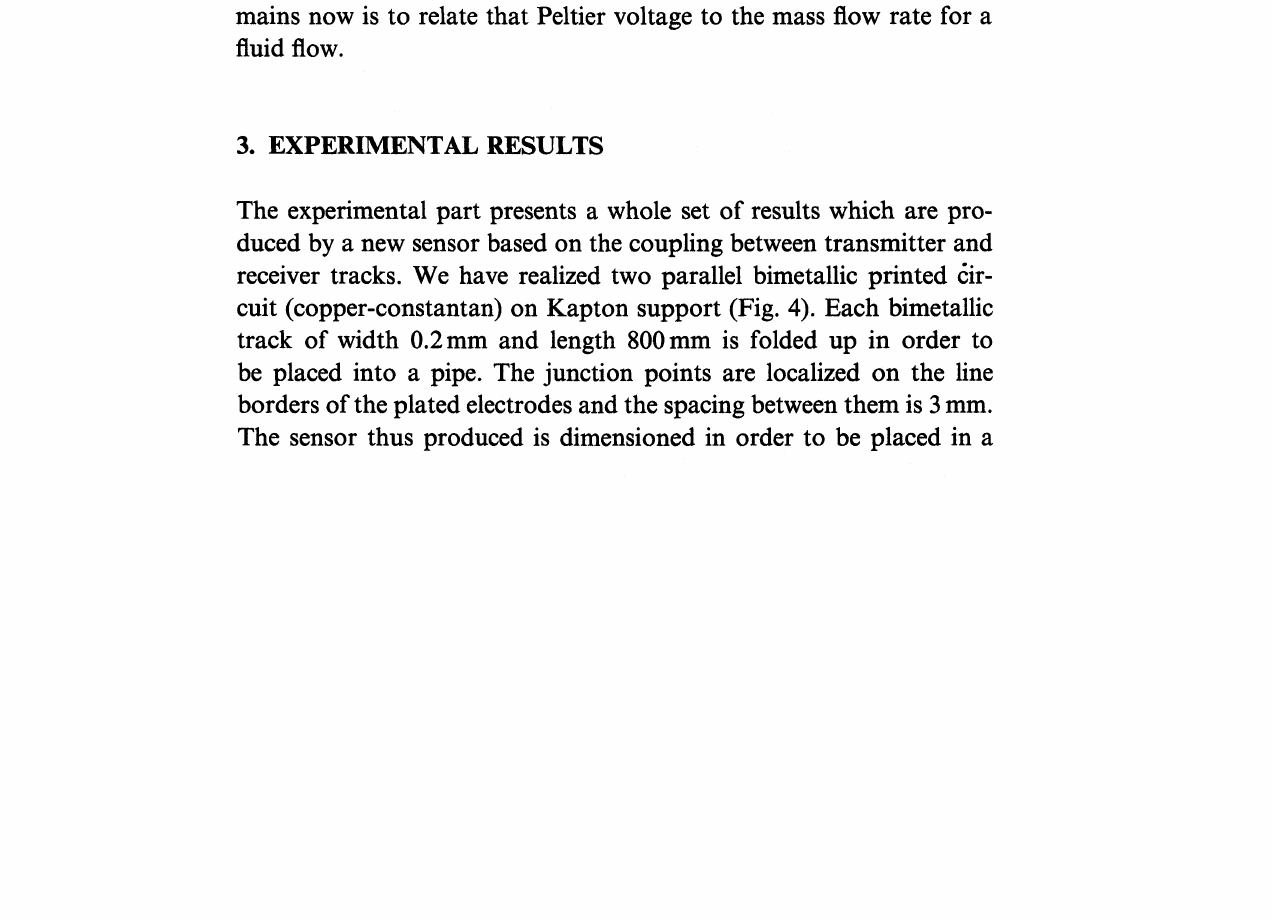
FIGURE 3 Section of the thermoelectric